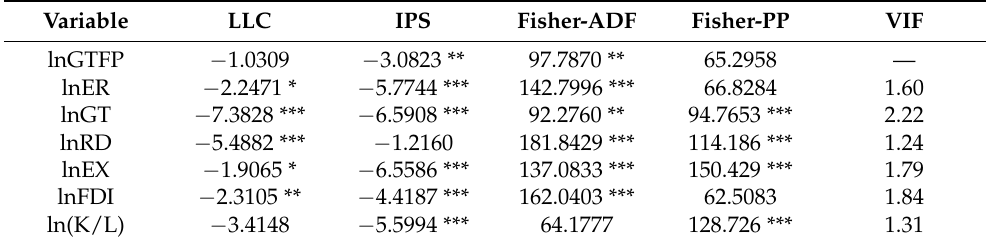
Table 2. Unit root and VIF test